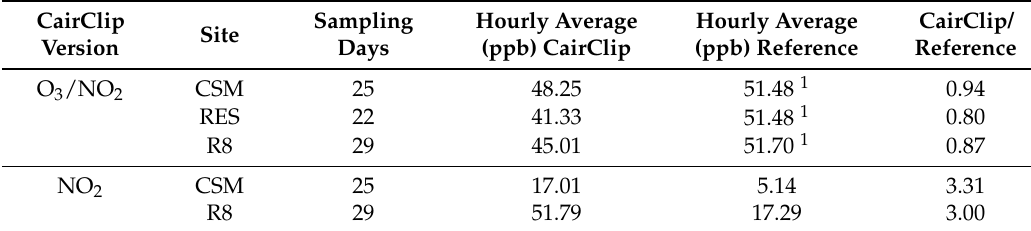
Table 3. Measurements at the citizen science sites during the Denver campaign.